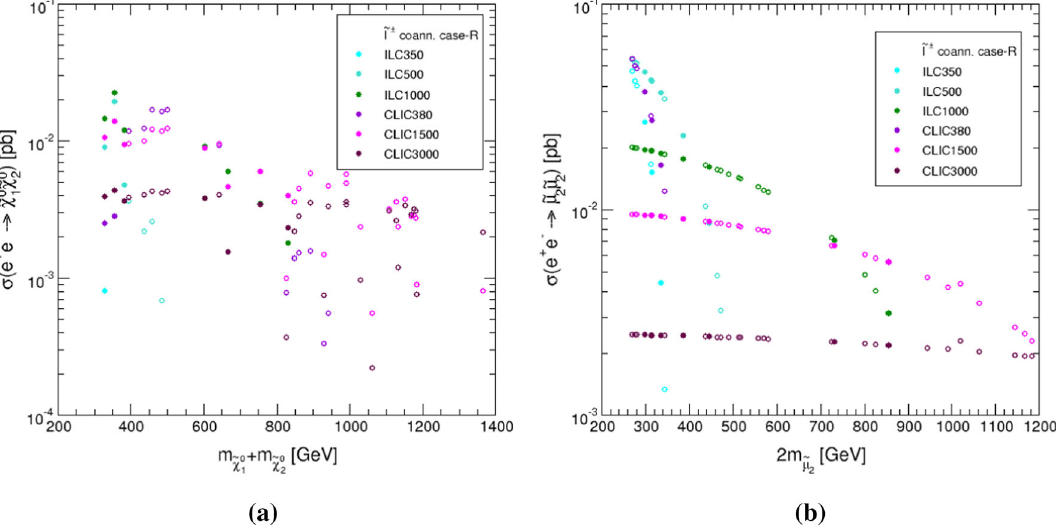
˜ χ 0 (left) and e + e − → ˜ μ 2 ˜ μ 2 (right) in the ˜ l ± -coannihilation Case-R at the ILC and CLIC as a 1 2